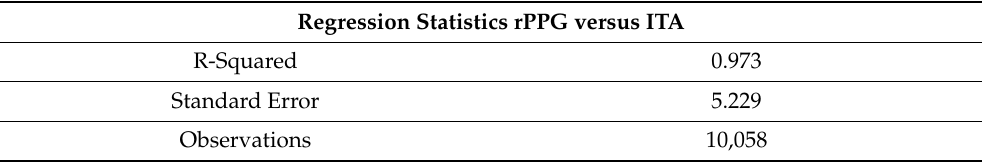
Table 5. Linear regression statistics of rPPG vs. ITA data with a 95% prediction